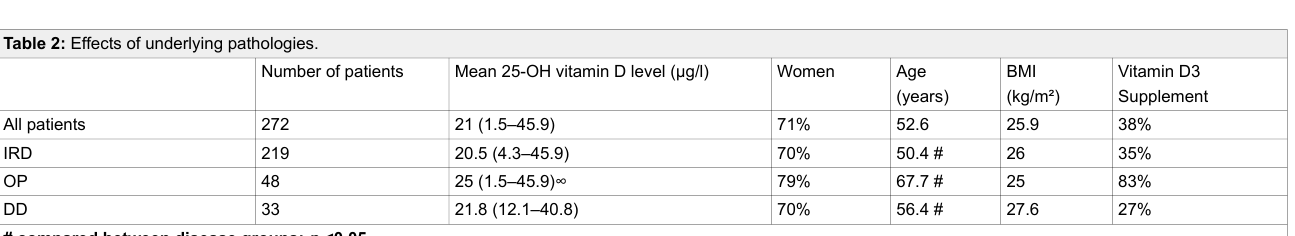
Table 2: Effects of underlying pathologies.